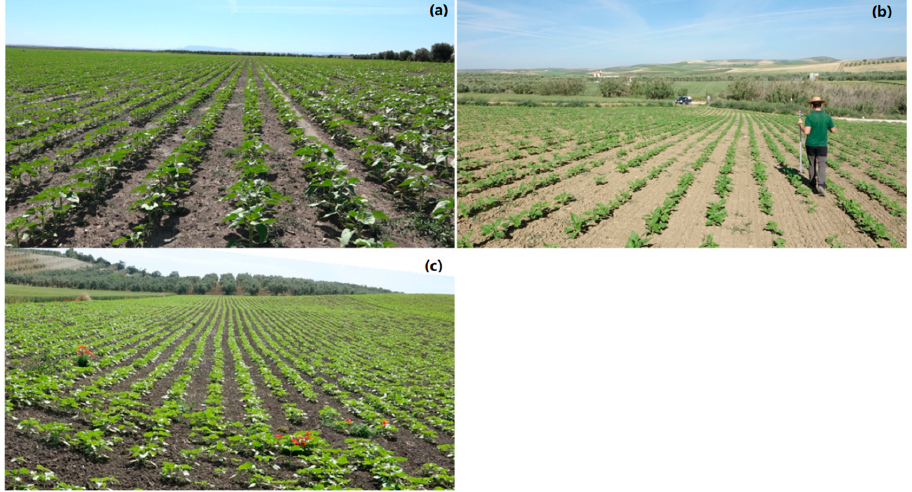
Figure 1. General view of the three studied sunflower crops in early stage: ( a ) S1–16; ( b ) S1–17; ( c ) S1–17.